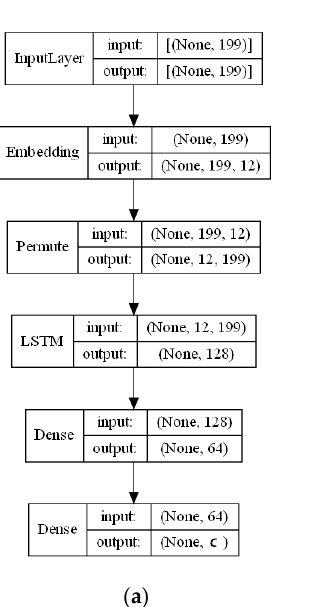
Figure A7. LSTM neural network topology. Used with LE vectorization ( a ), with ECFP vectorization ( b ).